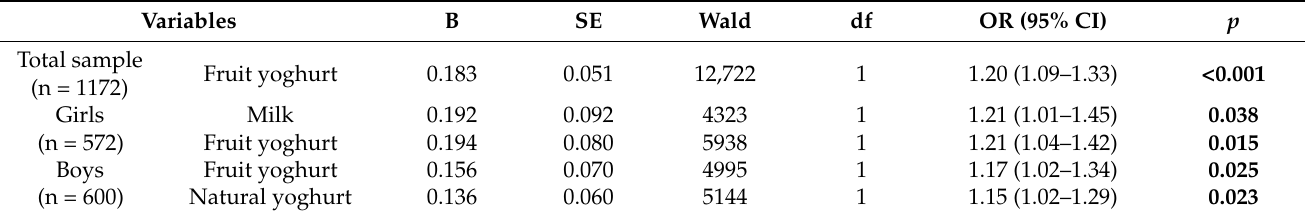
Table 5. Logistic regression analysis showing the association between dairy products consumption and excess